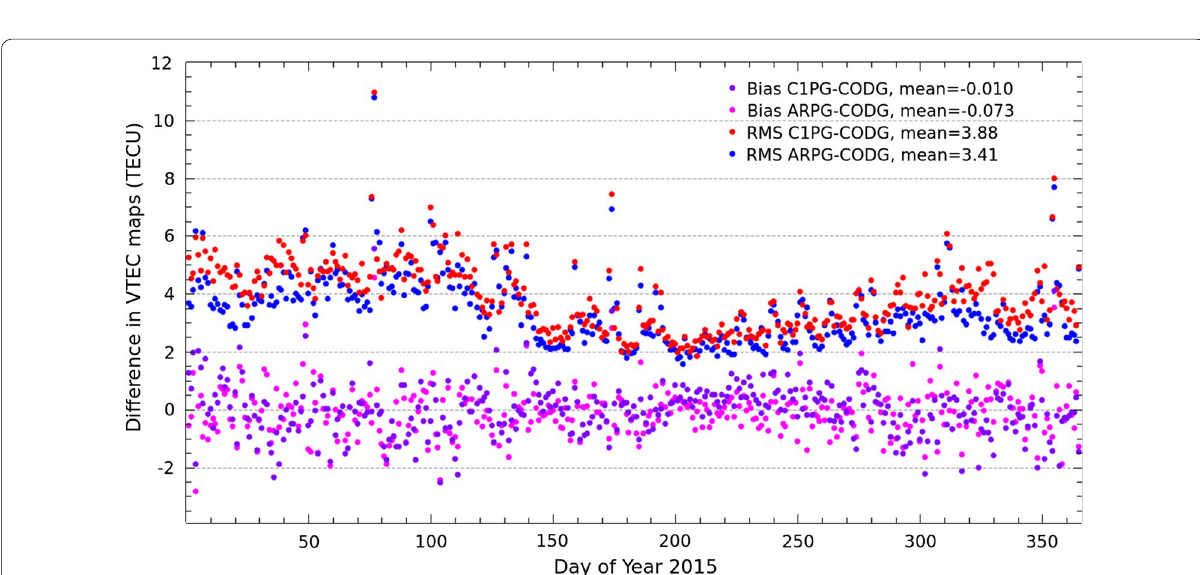
Fig. 4 Statistics of the differences in forecasting VTEC values (C1PG and ARPG) and final CODE VTEC values in 2015. The bias and RMS values of the differences are indicated by dots of different